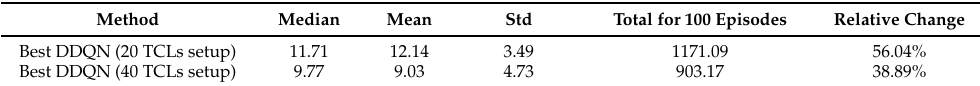
Table 4. Achieved decrease in deviations of actual power consumption from the reference power profile compared to the competing approach (proportional control) for 200 s period, in